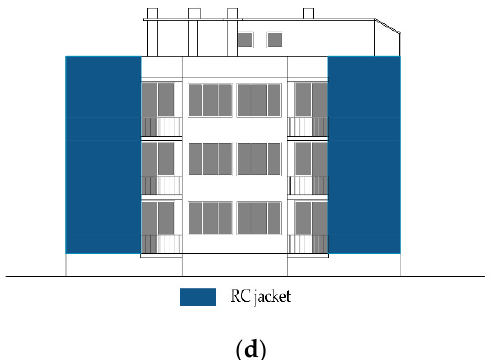
Figure 16. Elevations of the retrofitted building: ( a ) east façade; ( b ) west façade; ( c ) north façade, and ( d ) south façade.